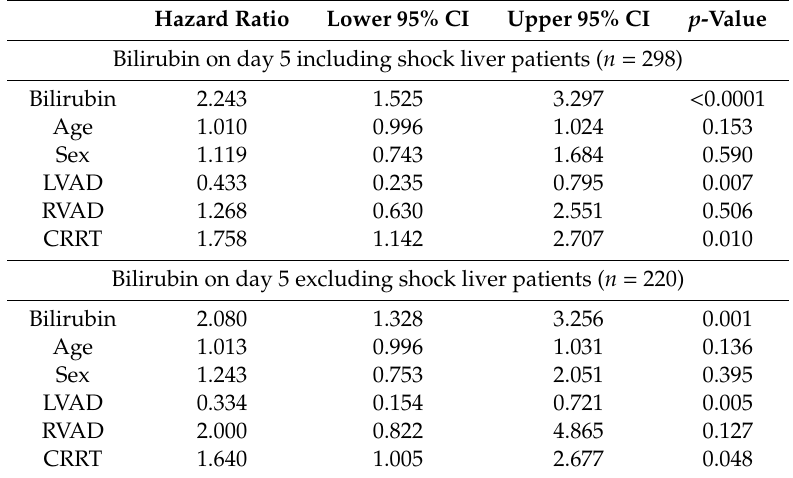
Table 2. Multivariate analysis for bilirubin with and without shock liver patients.